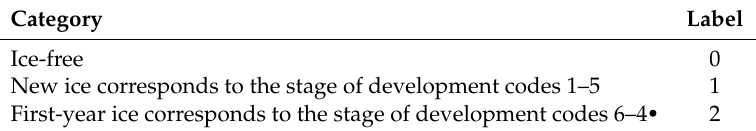
Table 1. Simplified labelling scheme reducing CIS egg codes to three